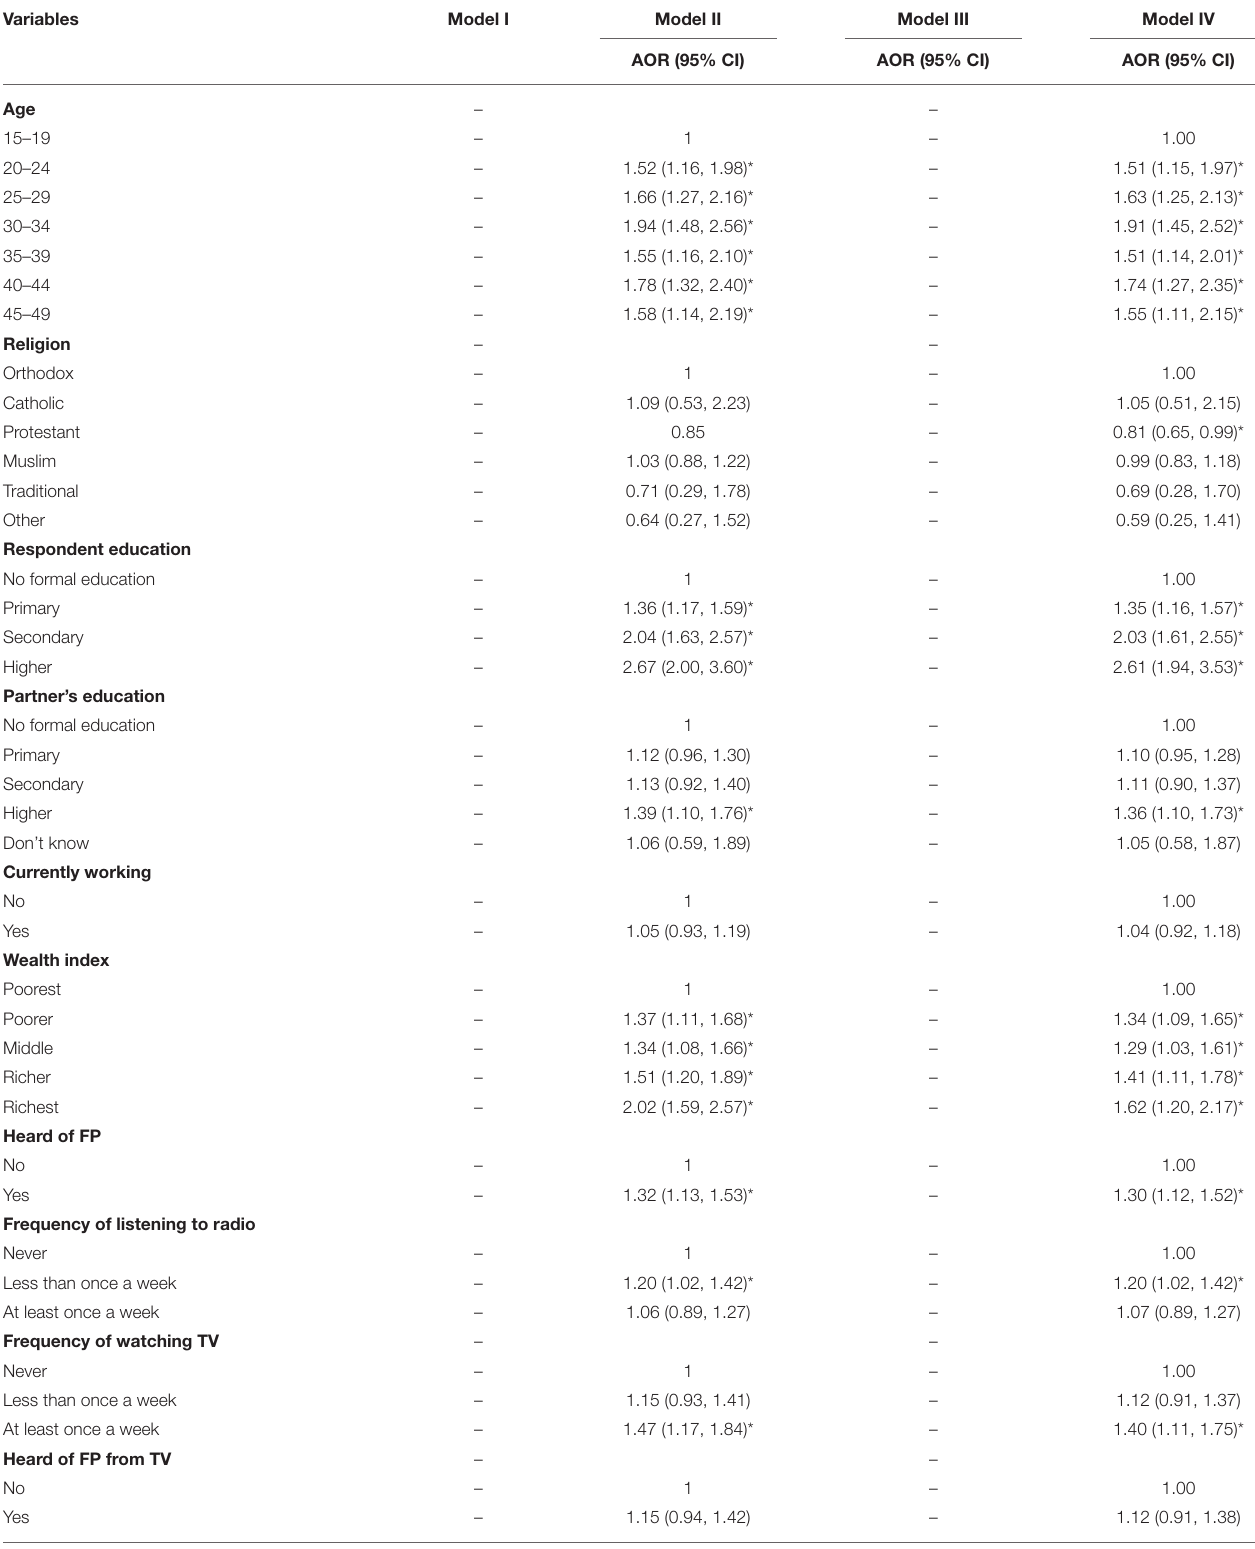
TABLE 3 | A multivariable multilevel analysis of Individual and community level factors associated with knowledge of fertile period among reproductive age women in Ethiopia, 2016 ( N =